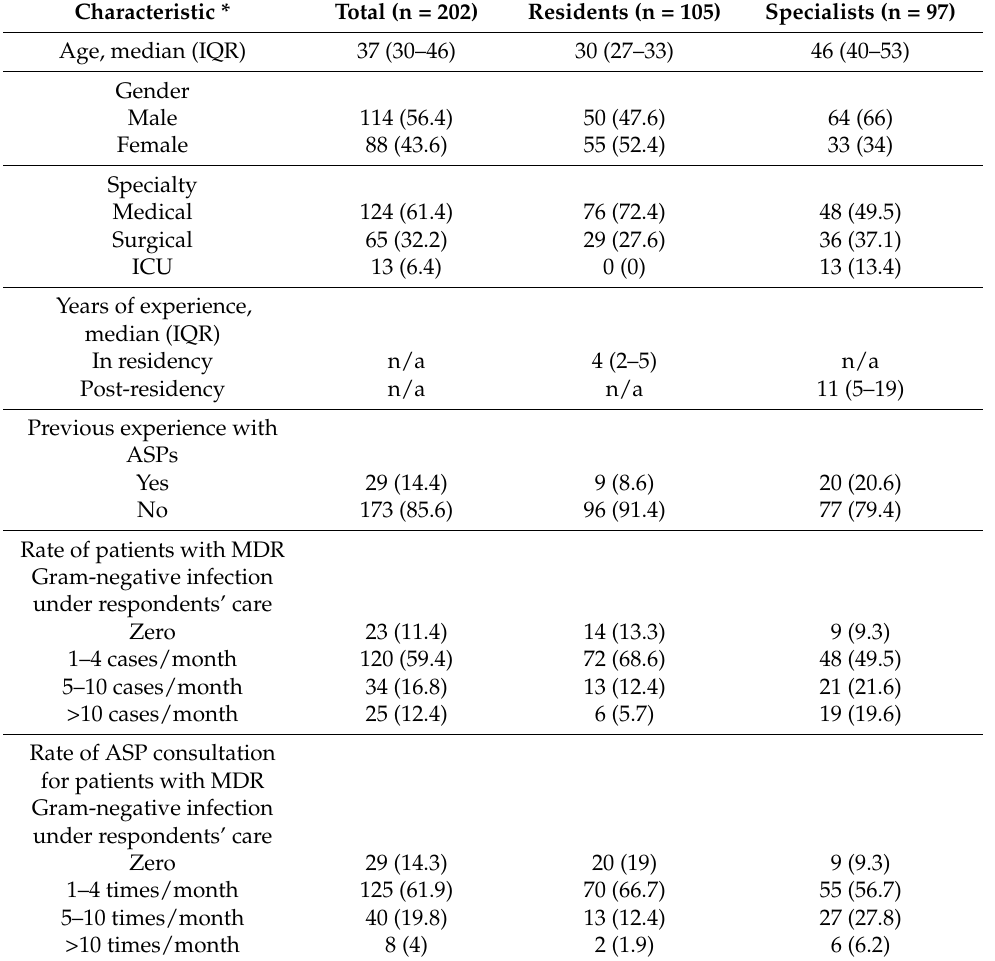
Table 1. Characteristics of the survey respondents and their experience with